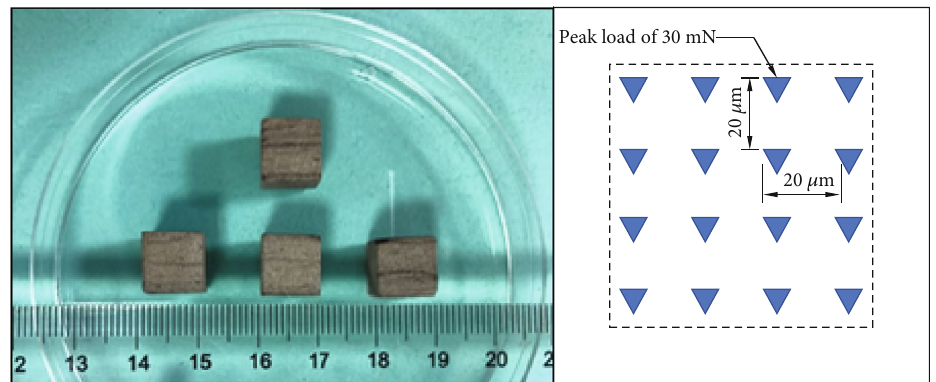
Figure 1: ESEM and nanoindentation specimen morphology and size with designed lattice form.